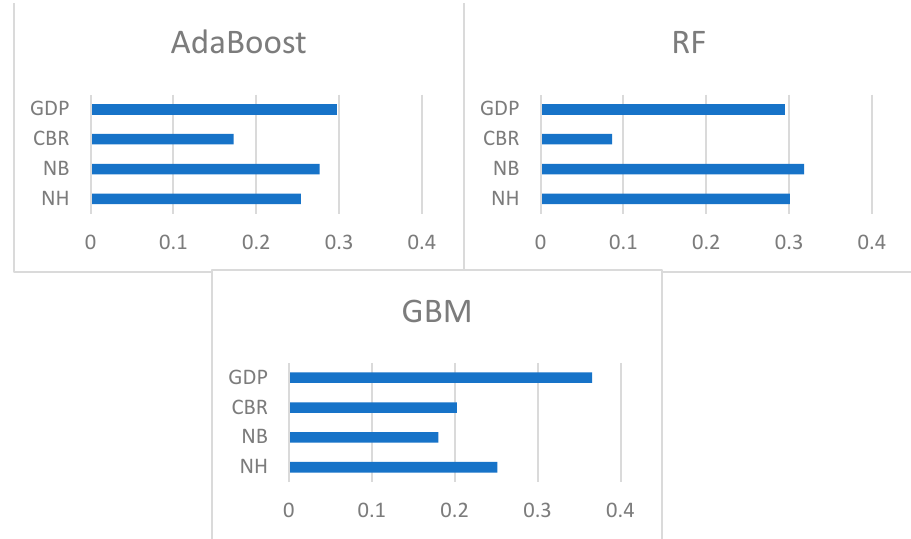
Figure 5. The feature importance of each single ML algorithm.